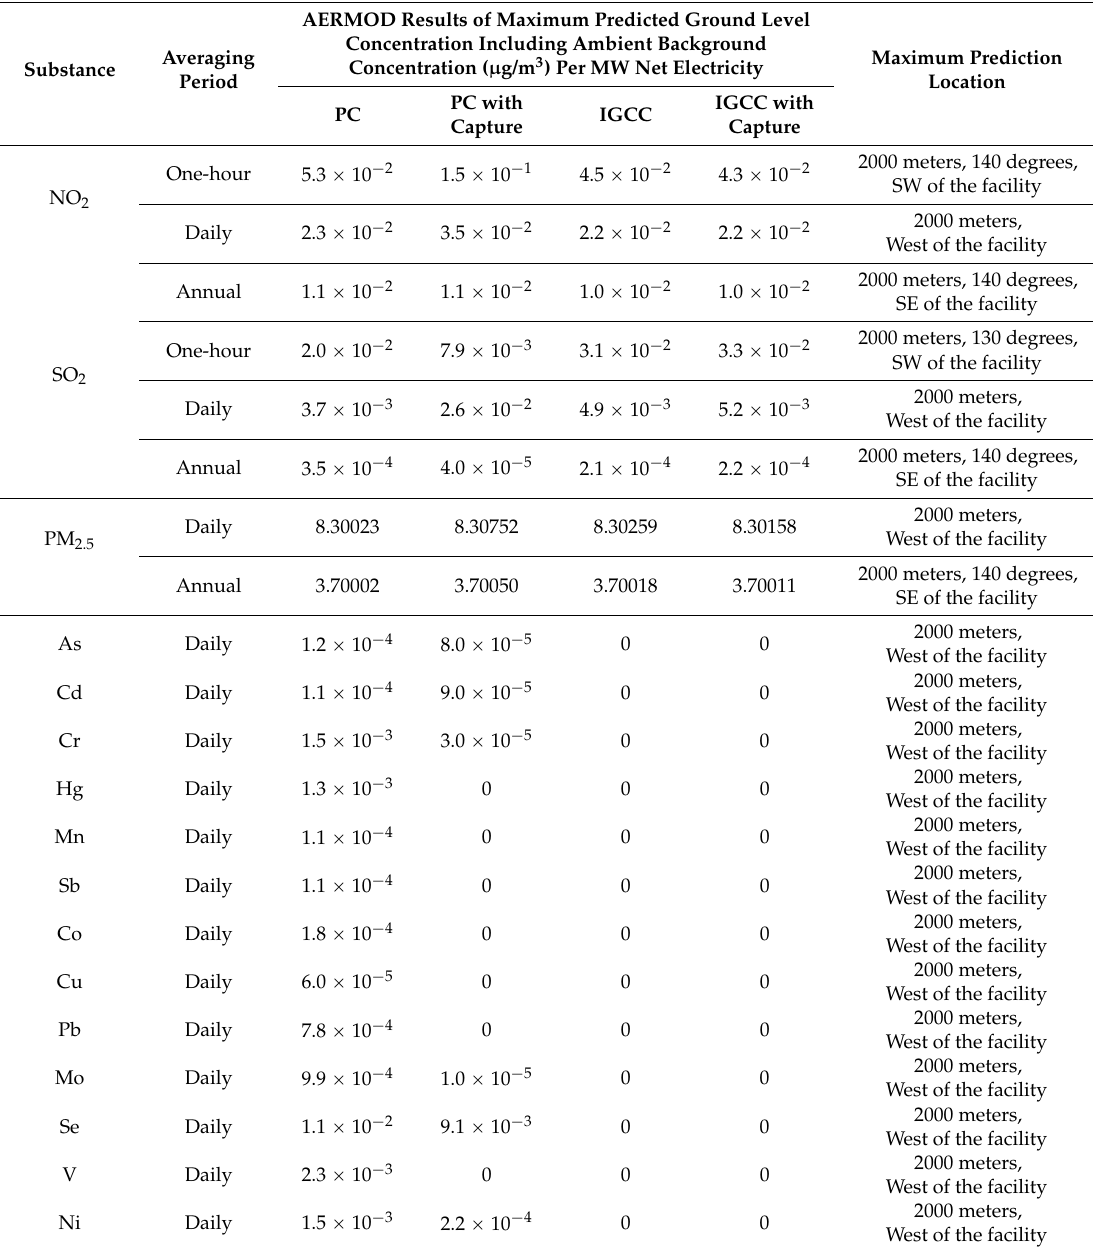
Table 10. AERMOD results: location of maximum predicted ground-level concentration including background concentrations Per MWe